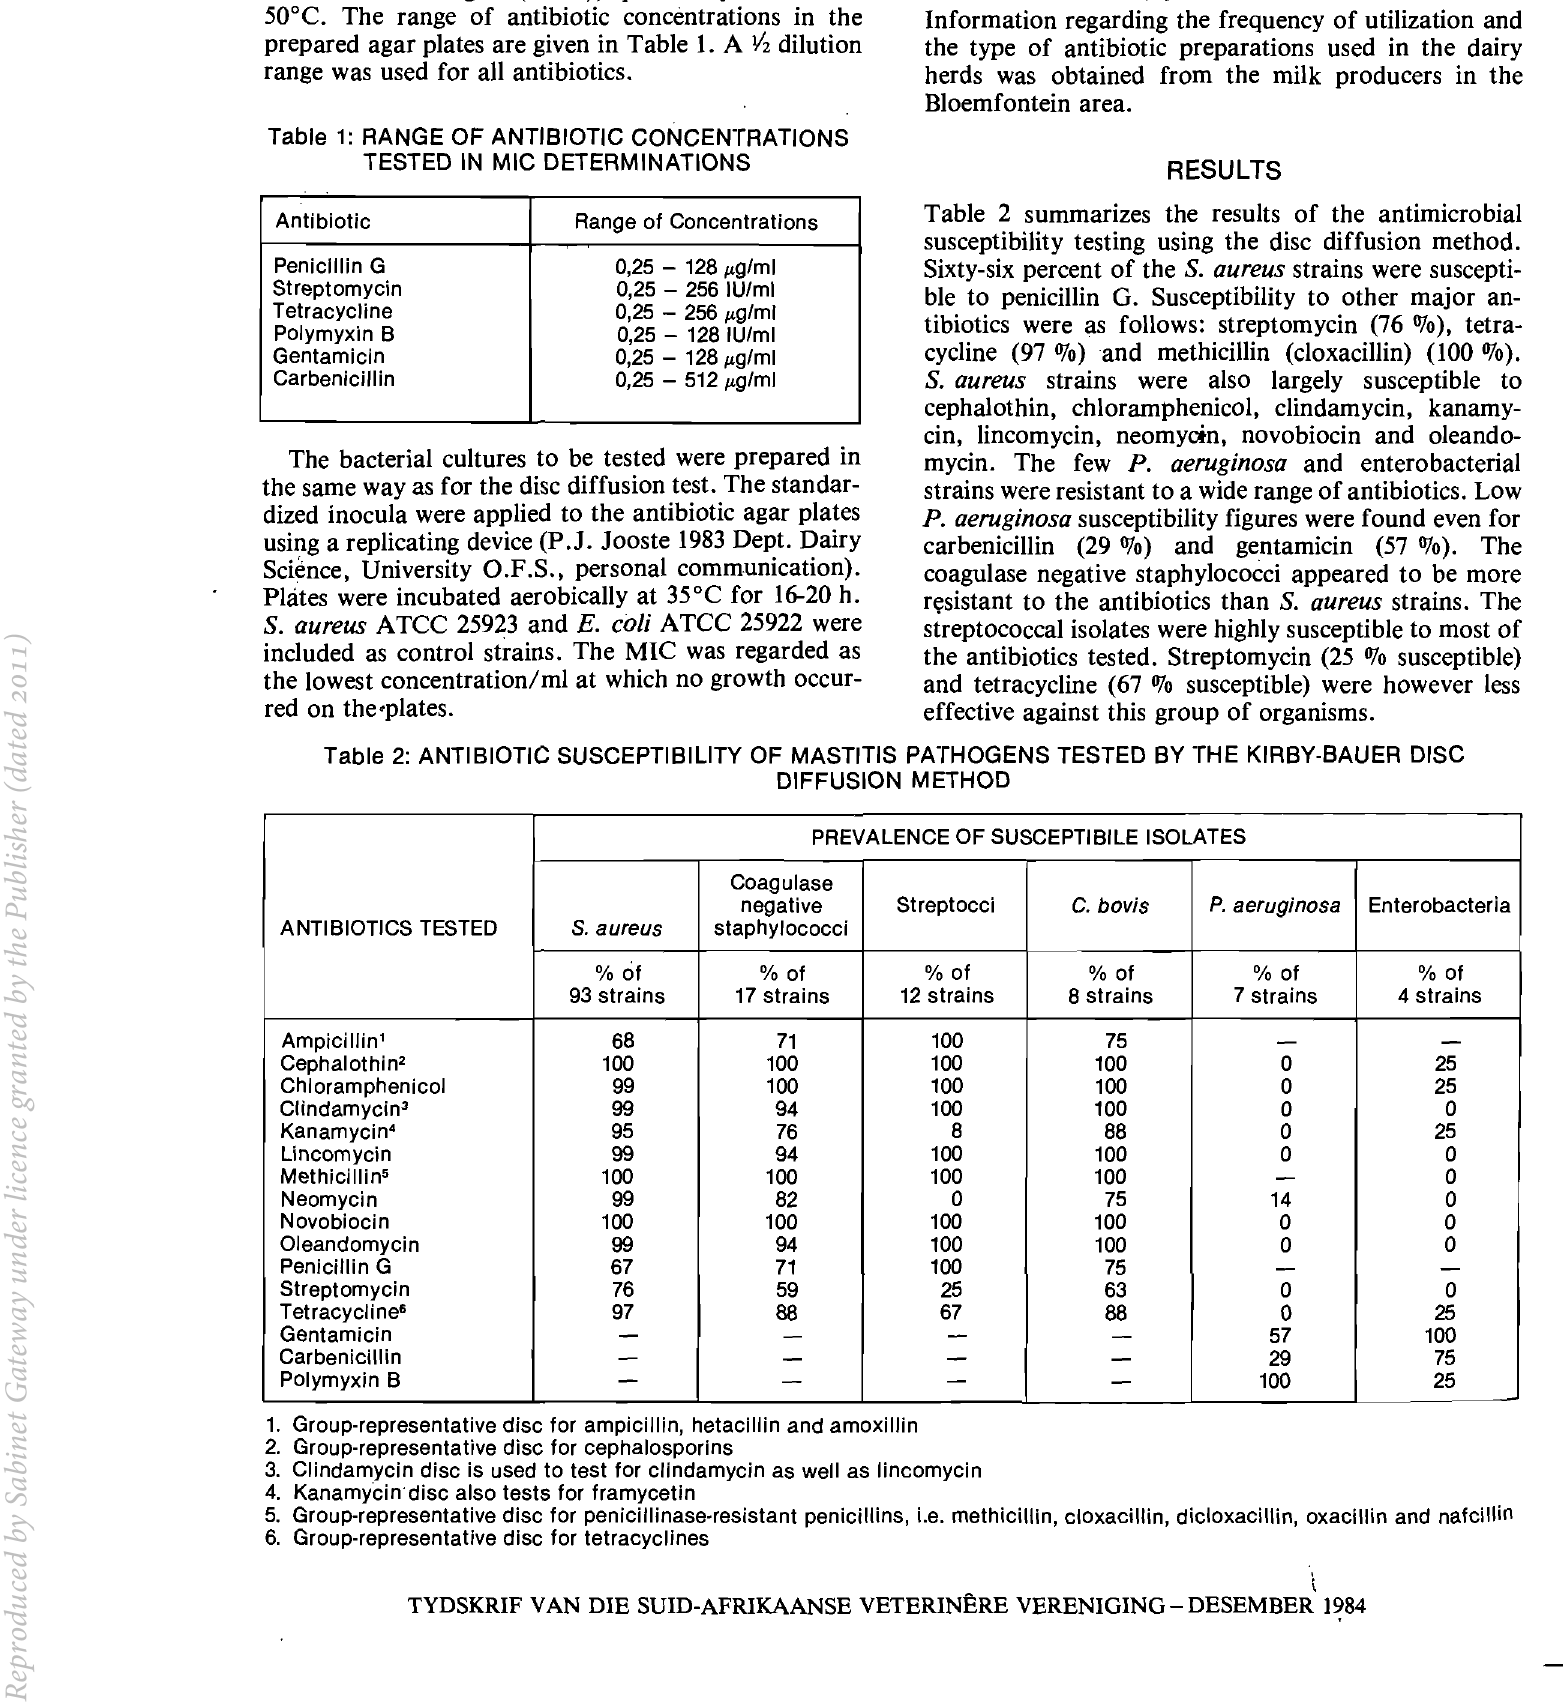
Table 1: RANGE OF ANTIBIOTIC CONCENTRATIONS TESTED IN MIC DETERMINATIONS Antibiotic Range of Concentrations